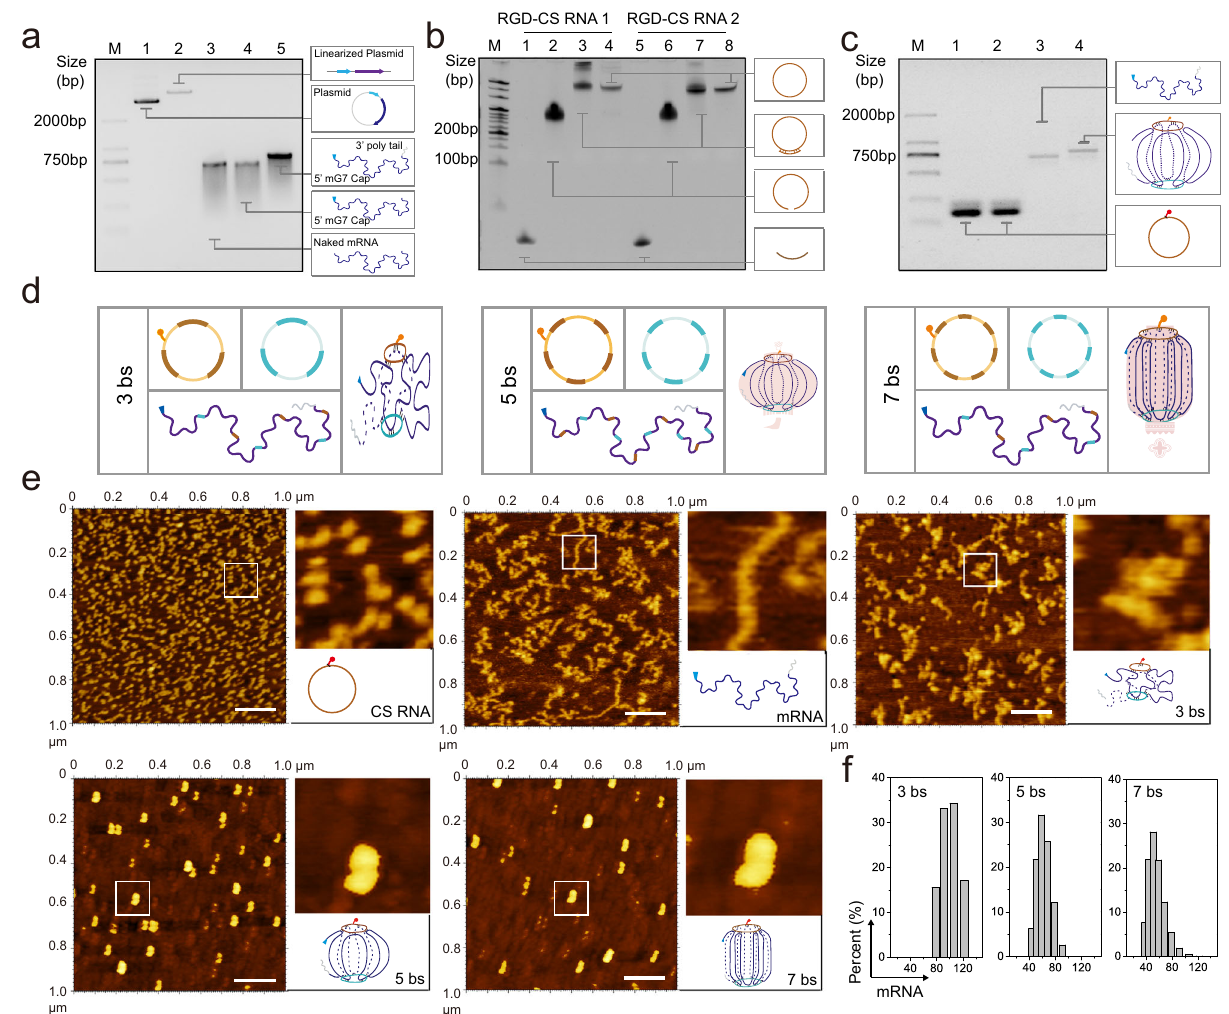
Fig. 2 | Construction and characterization of Smad4 mRNA nano-lantern. a – c Representative images from 3 independent experiments. Agarose gel electro- phoresis of mRNA synthesis and modi fi ed ( a ), urea-polyacrylamide gel electro- phoresis of circular RNA staples (5bs) synthesize ( b ), and formation of Smad4 mRNA nano-lantern ( c ). ( d ) Possible structures of the Smad4 mRNA nano-lantern